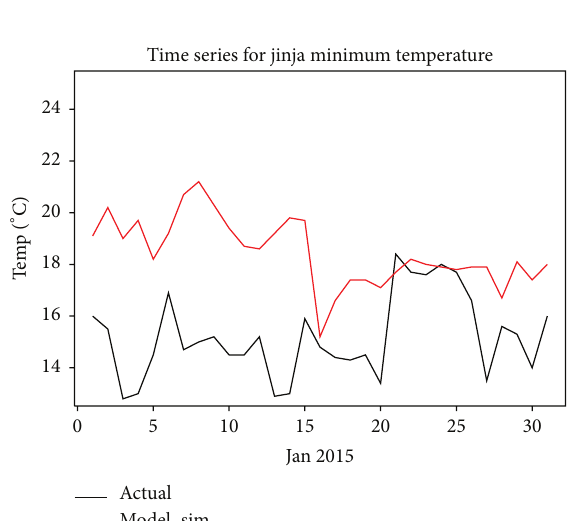
Figure 7: Jinja: max temp.